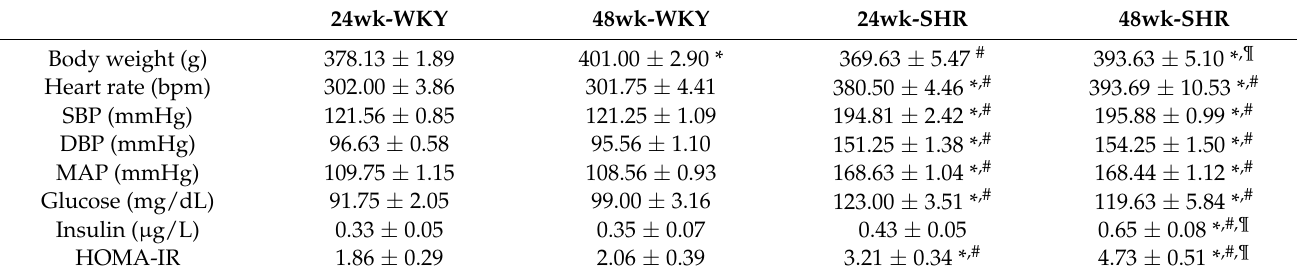
Table 1. General characteristics.